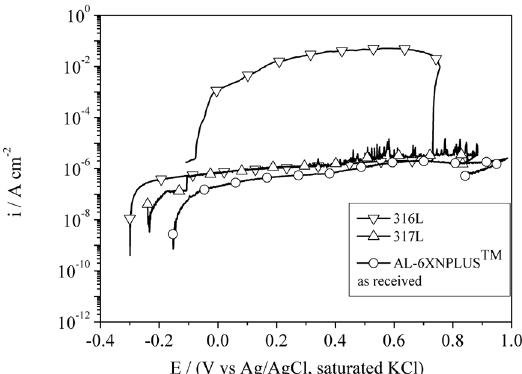
Figure 11. Cyclic polarization curves for the alloys in the as- received condition in aerated synthetic oil field formation water . without bubbling CO 2